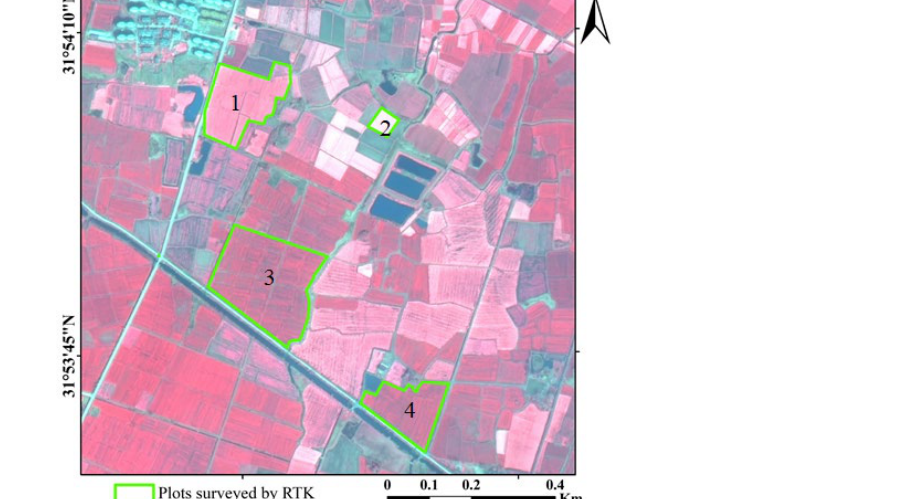
Figure 4. Manual carrying of RTK to measure the area of the plot (numbers 1 and 2 are rape plant- ing sites, and 3 and 4 are winter wheat planting sites). Table 3. Error analysis of the actual measured plot area and remote sensing image area.